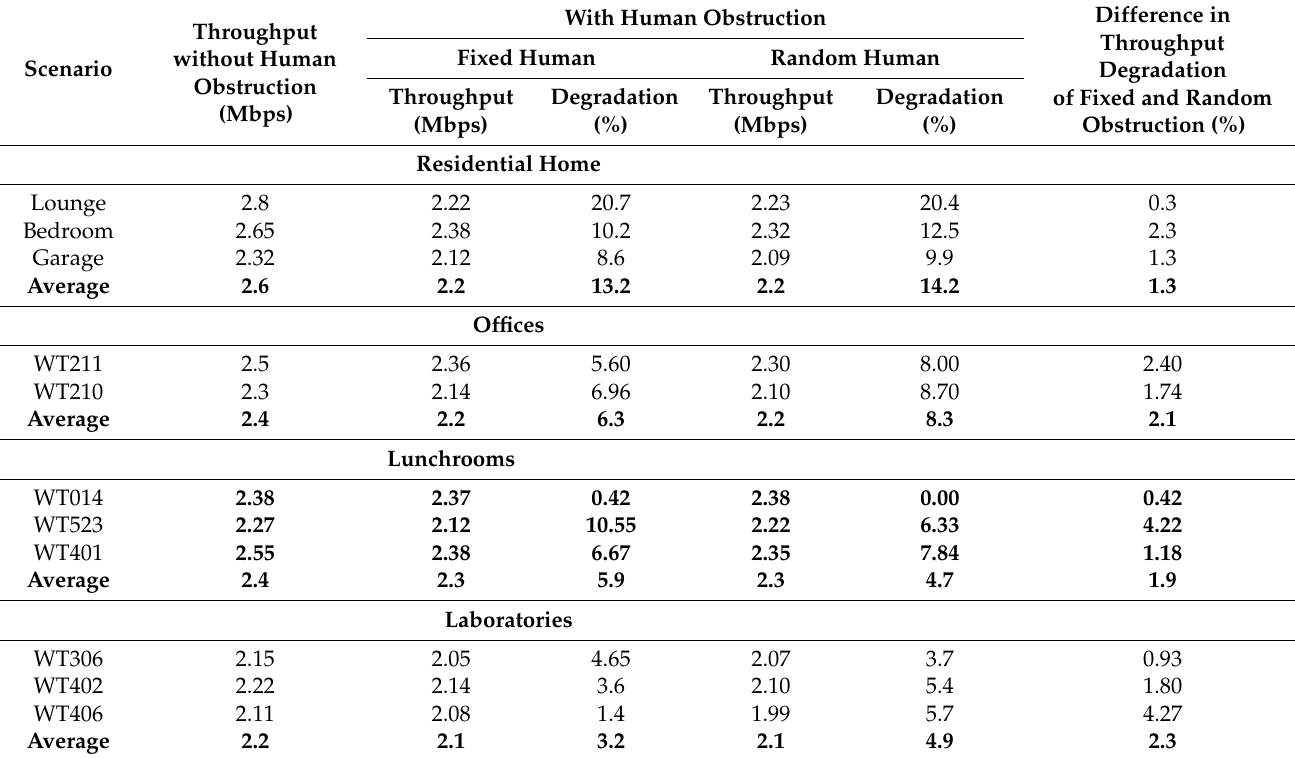
Table 4. Comparison of Wi-Fi link throughput